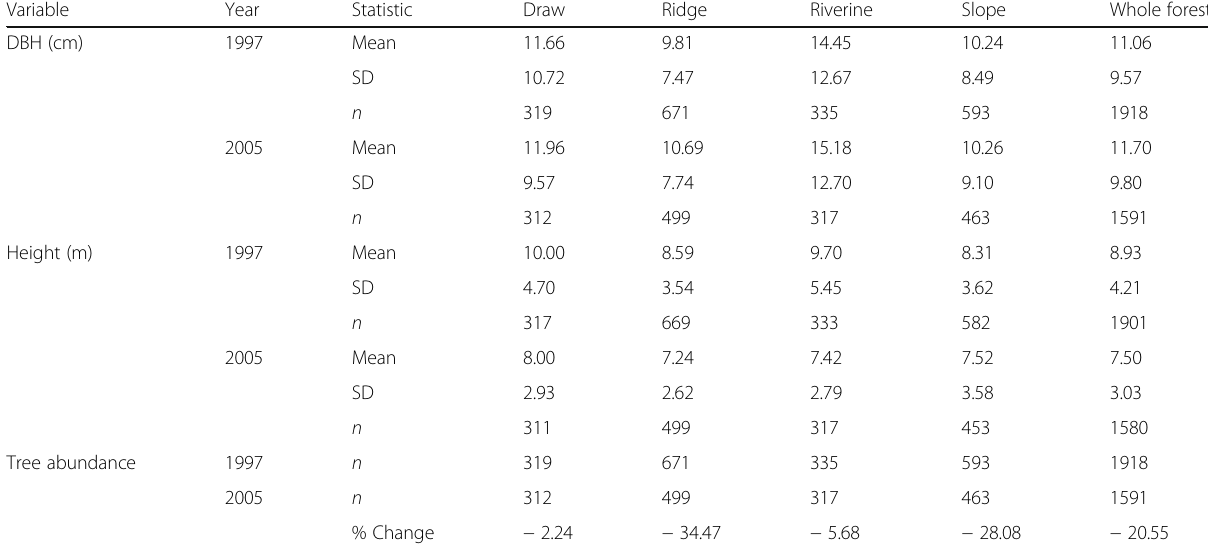
Table 3 Descriptive statistics for forest structure metrics by landform type in 1997 and 2005 Variable